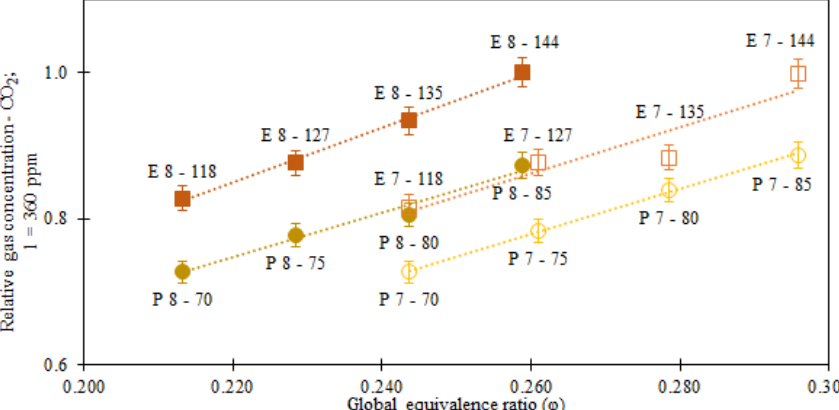
Figure 7. CO 2 concentration vs. the global equivalence ratio. Each value was normalized to the highest of the whole set. Data points are labelled with E or P (ethylene or propane) and a pair of numbers indicating air and fuel flow, respectively (Lmin − 1 ; mLmin − 1 ). Dotted lines aim to guide the reader’s eye.